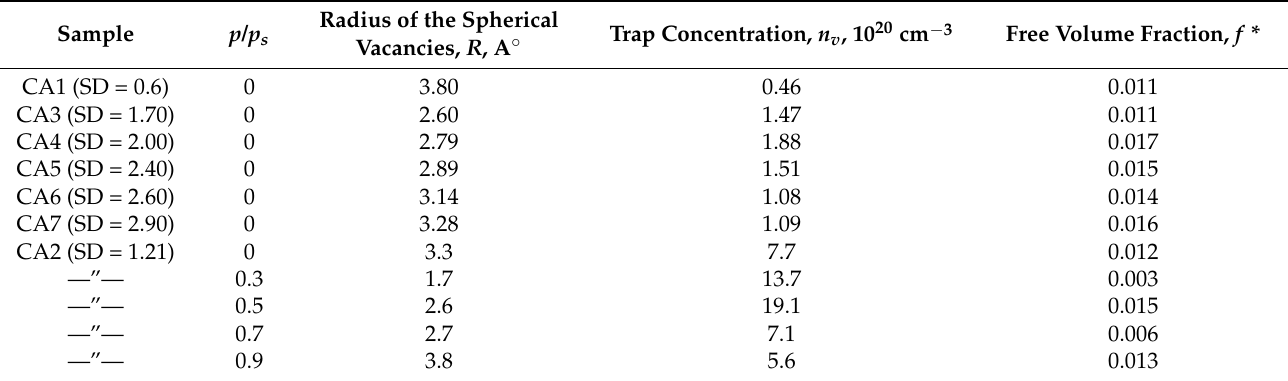
Table 2. Free volume parameters in CA films (T = 20 ◦